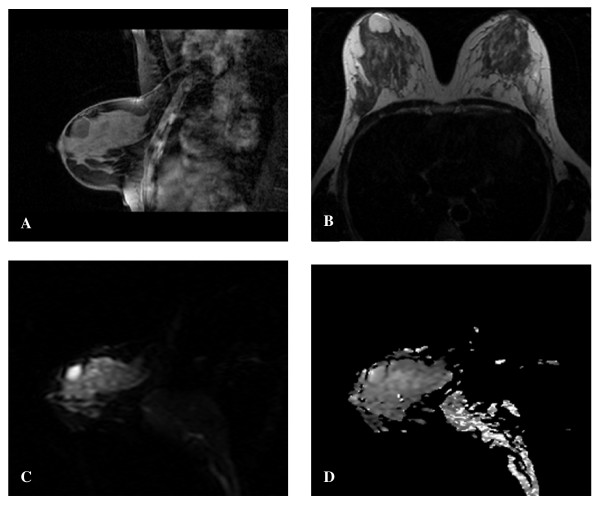
36-year-old woman with fibroadenoma in right breast. A: WATS T1-weighted sagittal scan showed a regular round slightly hypointense lesion. B: T2-weighted transverse scan showed a round and smooth hyperintense lesion in the right breast. C: EPI-DWI sagittal scan showed a hyperintense lesion in DWI. D: The isointense lesion was in ADC map (b = 1000) and the ADC was 2.44 ± 0.362×10-3mm2/s.